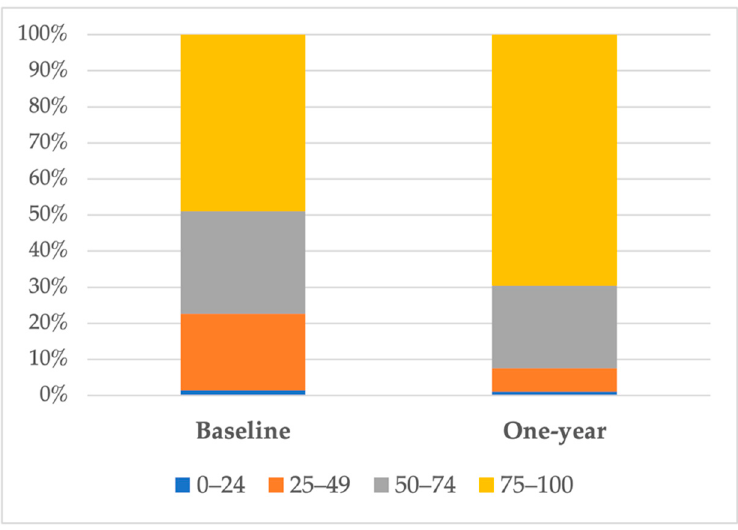
Figure 3. Change in KCCQ-12 at one-year follow-up.